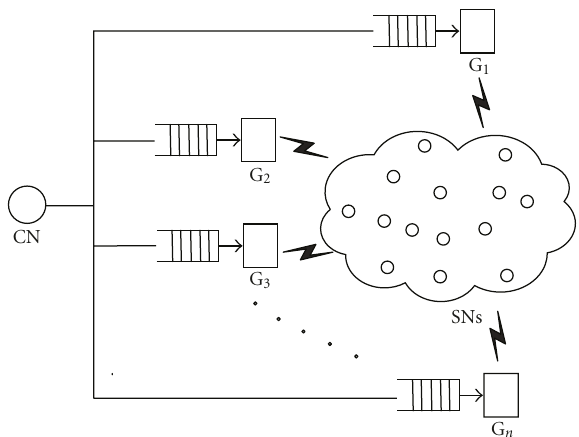
Figure 9: Network topology for ns2 simulations (Sections 6.1–6.3).